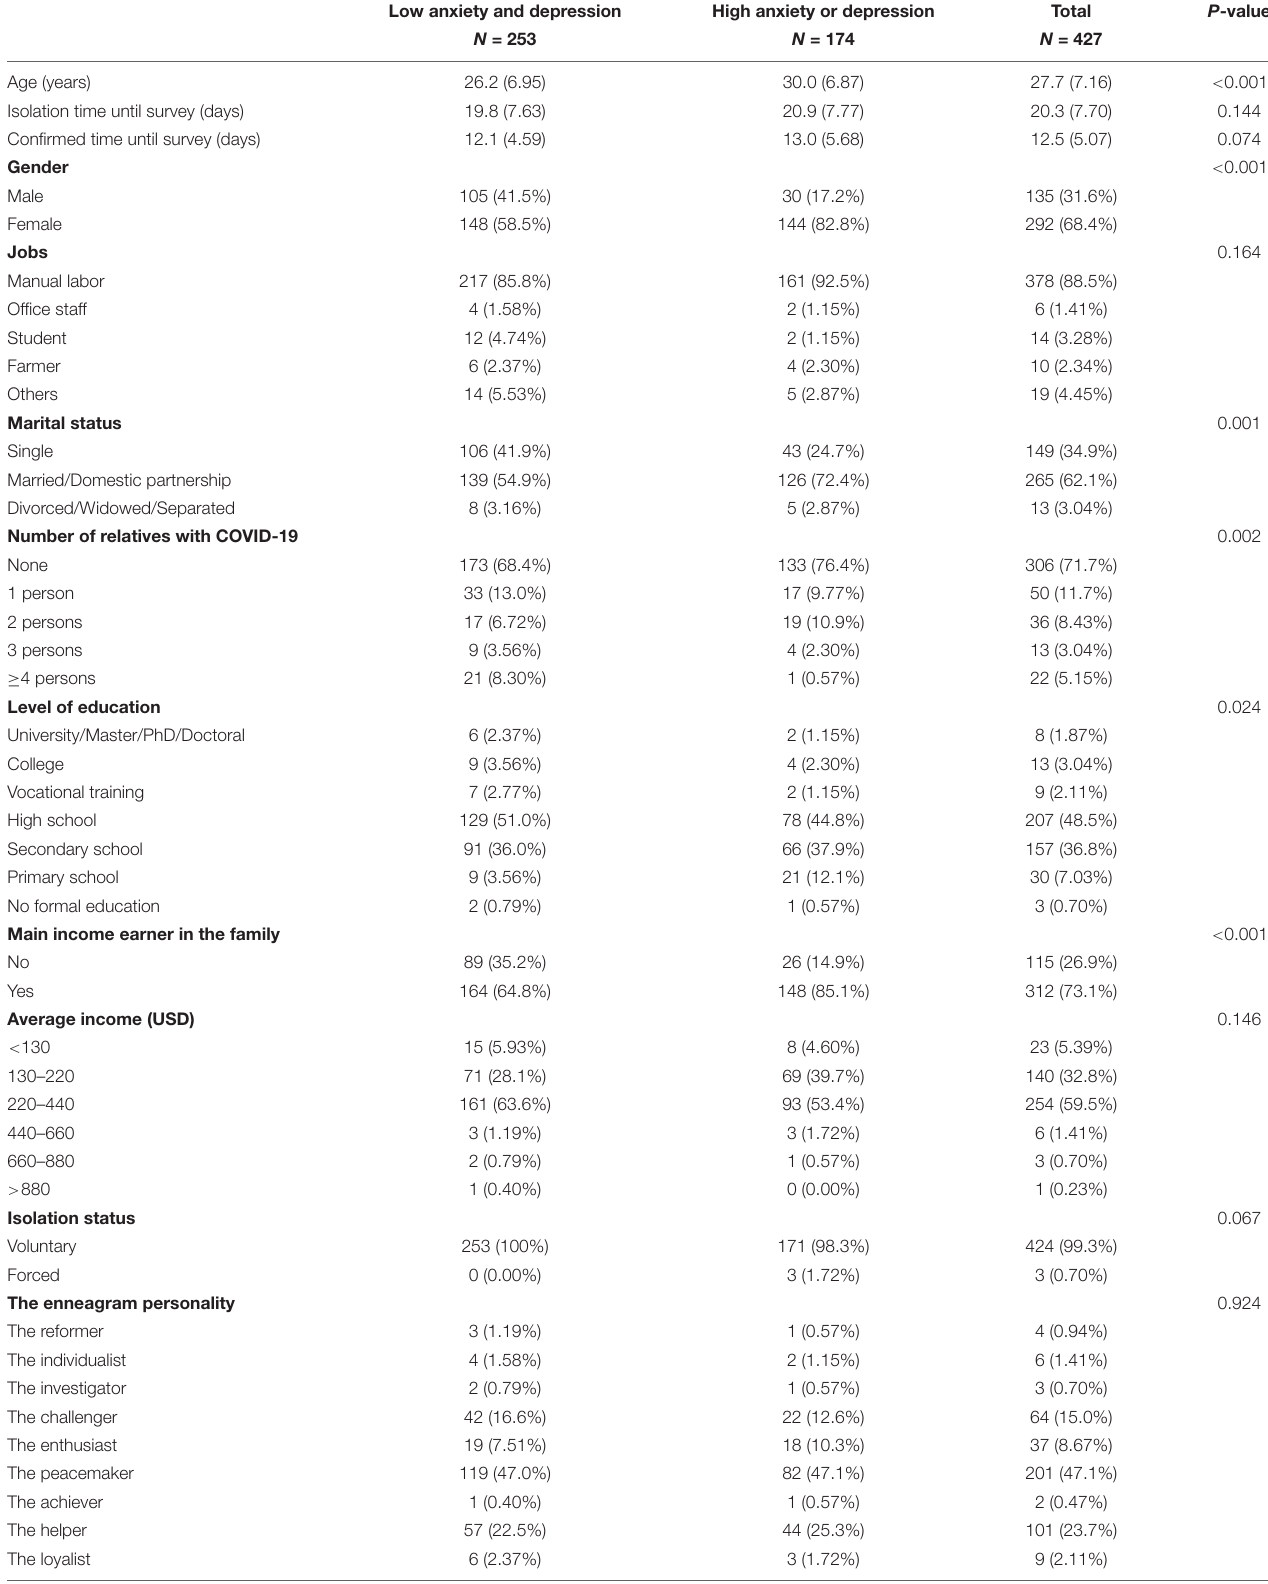
TABLE 1 | Sociodemographic characteristics by anxiety and depression status. Low anxiety and